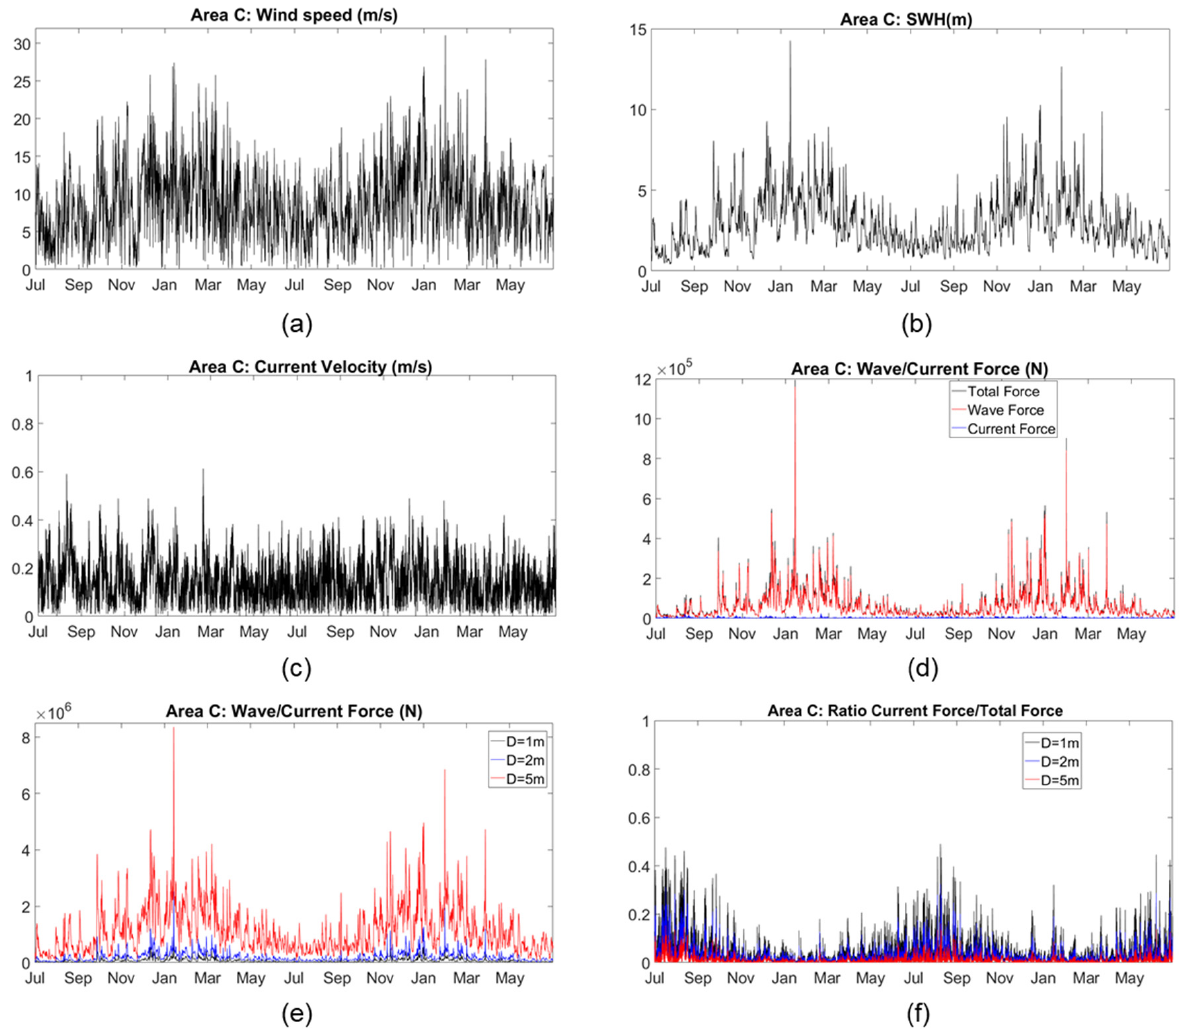
Figure 10. Area C hourly time series (7/2014–6/2016) of area-averaged wind speed (m/s) ( a ) Significant Wave Height (m) ( b ), Current velocity (m/s) ( c ), total wave/current force (N) (black), wave force (N) (red) and current force (N) (blue) ( d ) on a pile of diameter 𝐷 = 1 m. Timeseries of total force ( e ) and ratio of current to total Force ( f ) for 𝐷 = 1 m, 𝐷 = 2 m, and 𝐷 = 5 m.